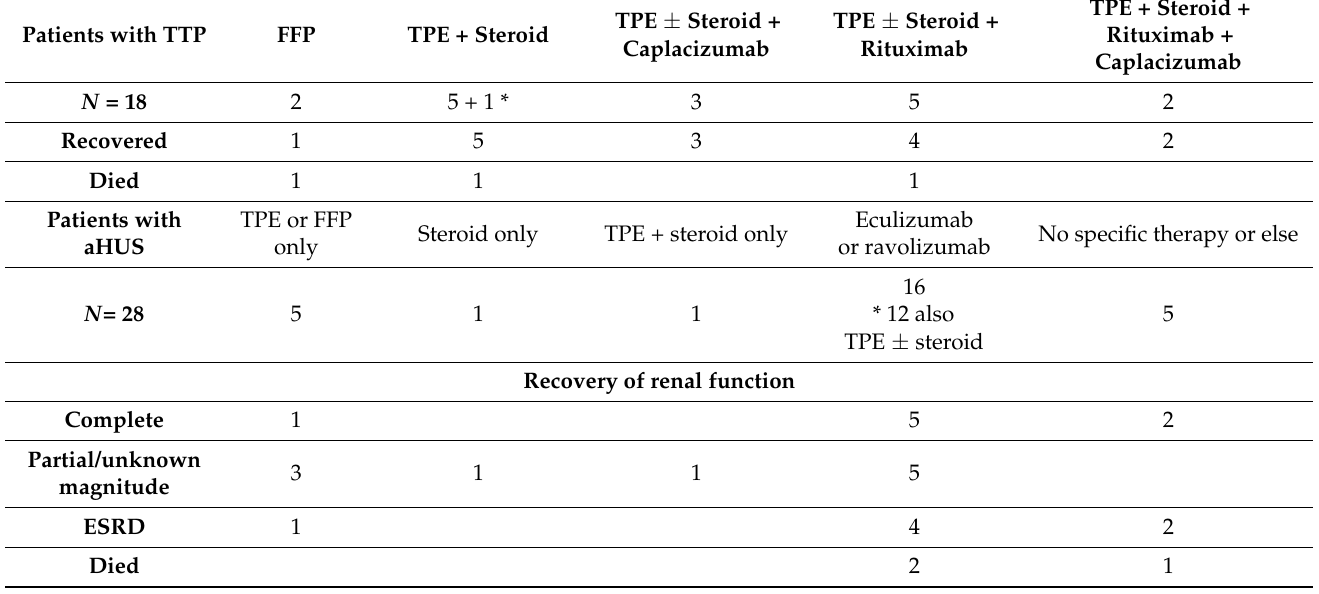
Table 3. Outcomes in patients with COVID-19-associated TMA in relation to received